Question: Identify the chart type used in this figure.
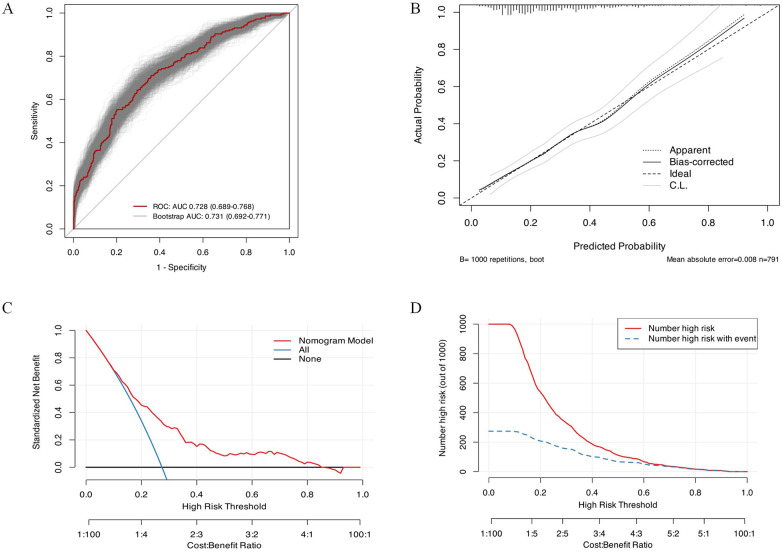
Answer: line